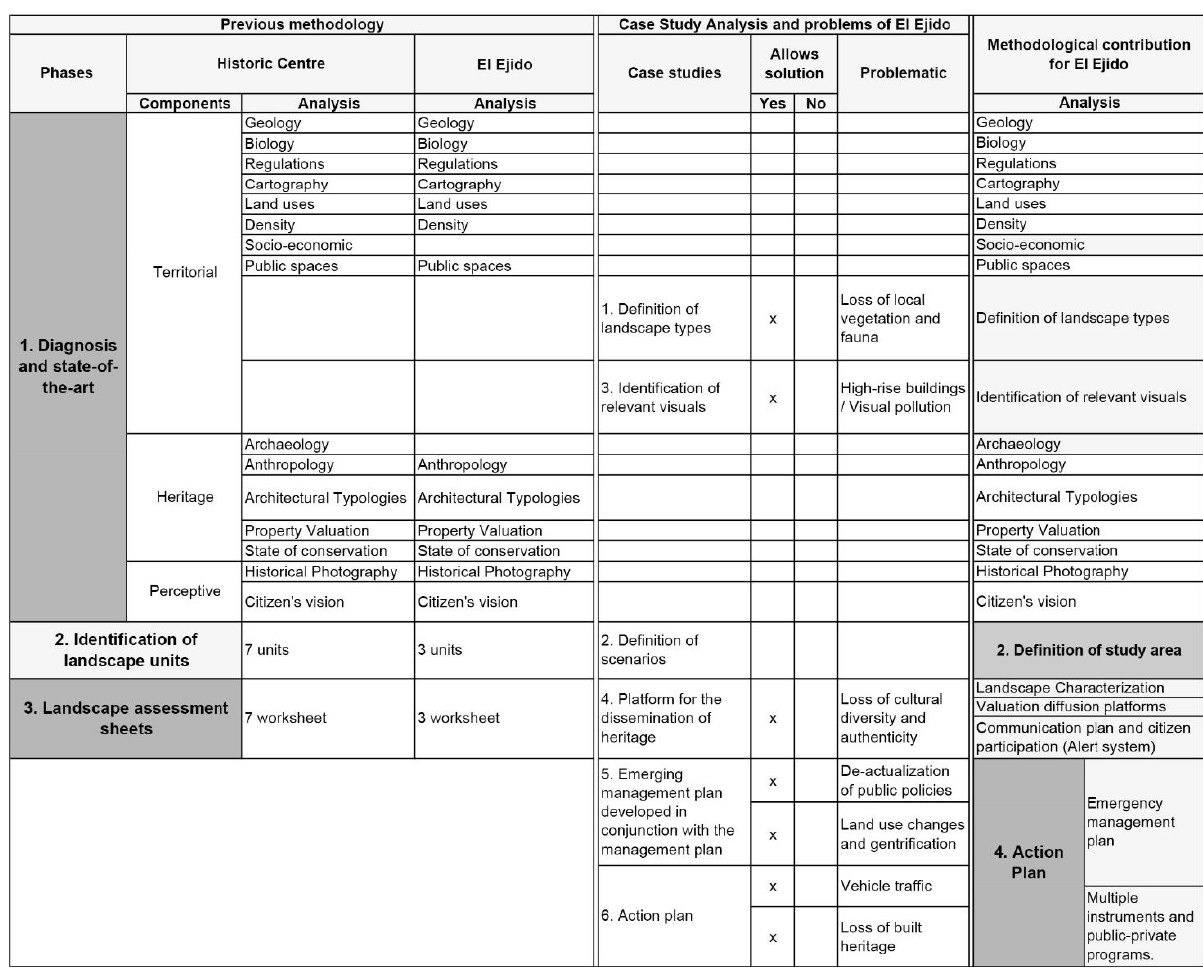
Table 1. Analysis of the comparison between the existing methodology, case studies, and the problems of the El Ejido, for the methodological